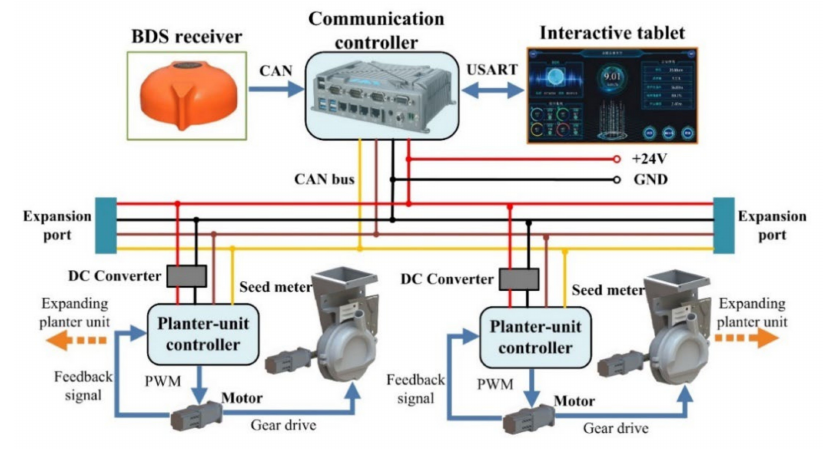
Figure 2. Components of electric-driven seeding control system.